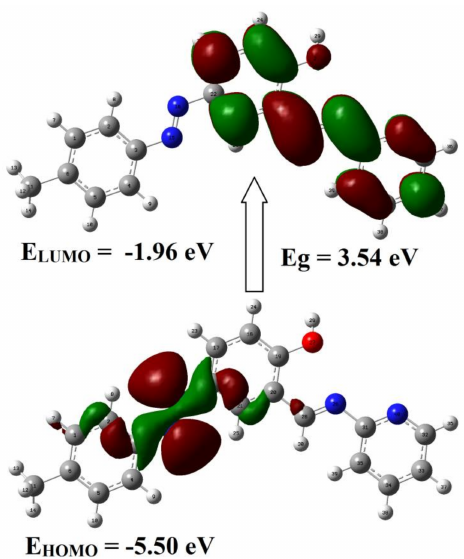
Figure 3. HOMO, LUMO and energy difference of ligand.